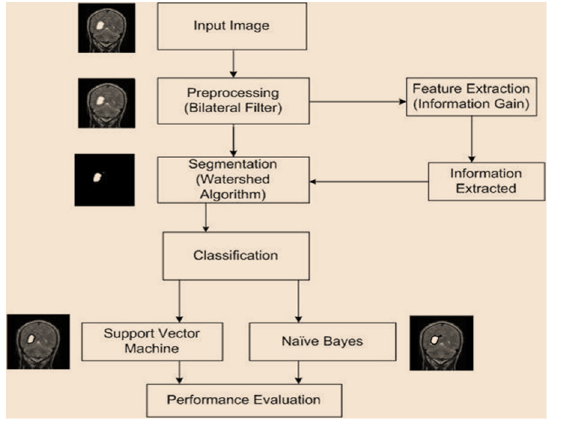
Fig. 1: Flow Chart of Proposed Methodology